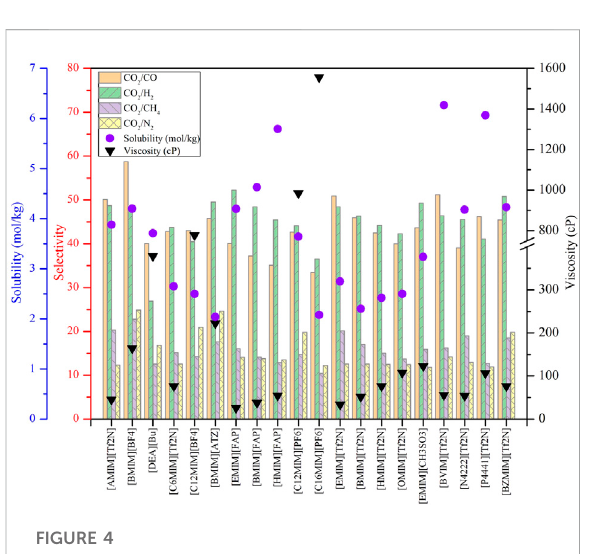
FIGURE 4 Top 20 physical-based ILs based on their